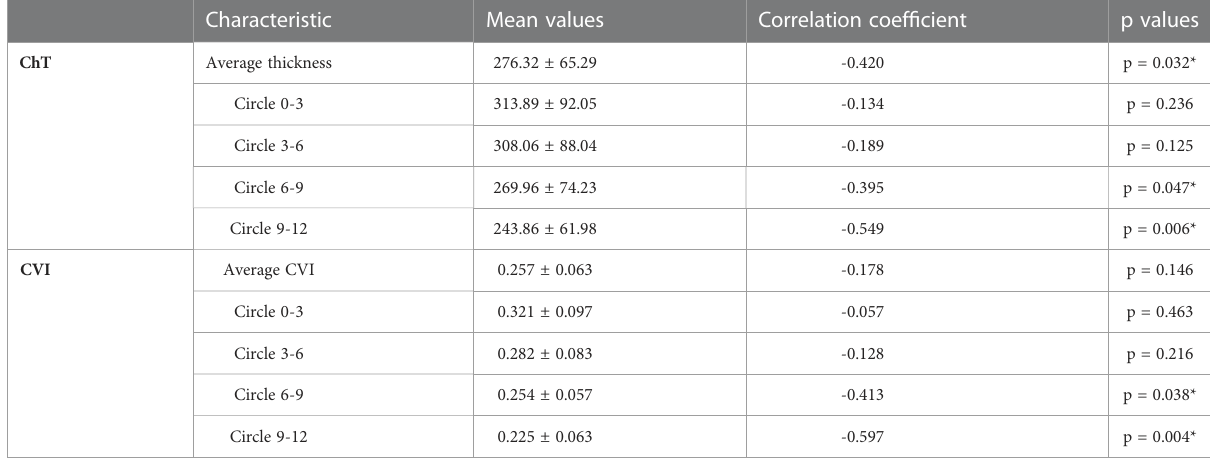
TABLE 4 The correlations between duration and choroidal characteristics in patients with diabetes